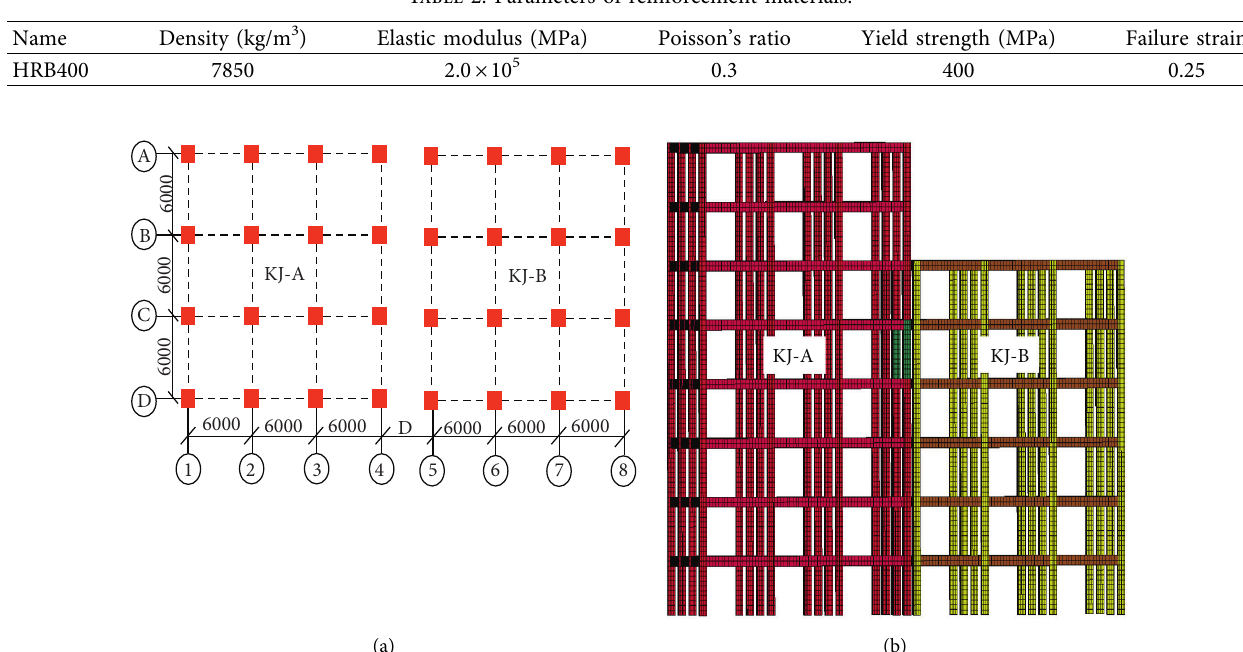
Table 2: Parameters of reinforcement materials.